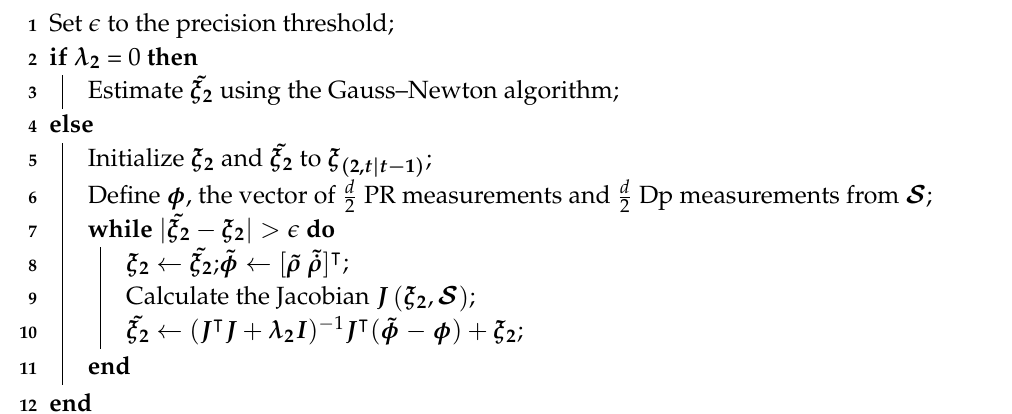
Algorithm A1: Estimation Based on the non-Linear Solver and Including the Regularization Term, Inputs: Matrix S , Whose Lines are the Observations ξ ( λ and Outputs ˜ ξ 2 ; the Same Algorithm to Estimate ˜ ξ 1 Omitting Dp Measurements ˜˙ ρ 2, t | t − 1 ) ,